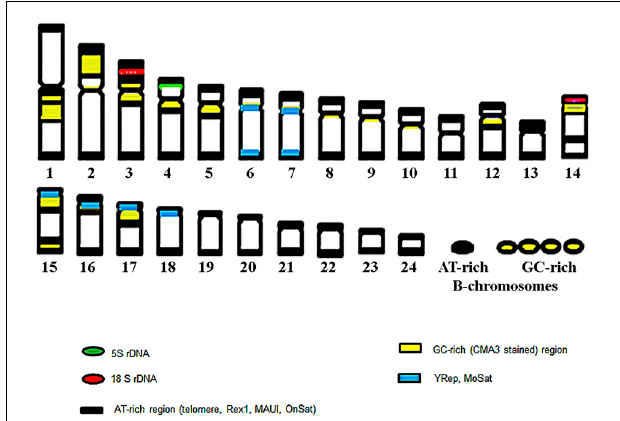
FIGURE 8 | The ideogram of the chromosome complement of Asian seabass exhibiting cytogenetic mapping of ribosomal sequences, repeats and, heterochromatic, AT- and GC-rich regions. Altogether, eight of the 24 autosomal chromosome pairs showed a unique hybridization profile with the various